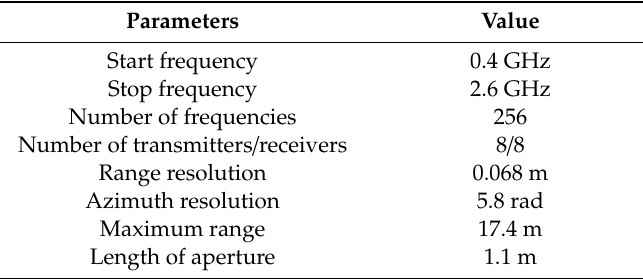
Figure 6. Simulations for the MIMO sparse array by: ( a ) the time domain back projection (TDBP) algorithm; ( b ) the cross-correlation-based time domain back projection (CC-TDBP) algorithm.